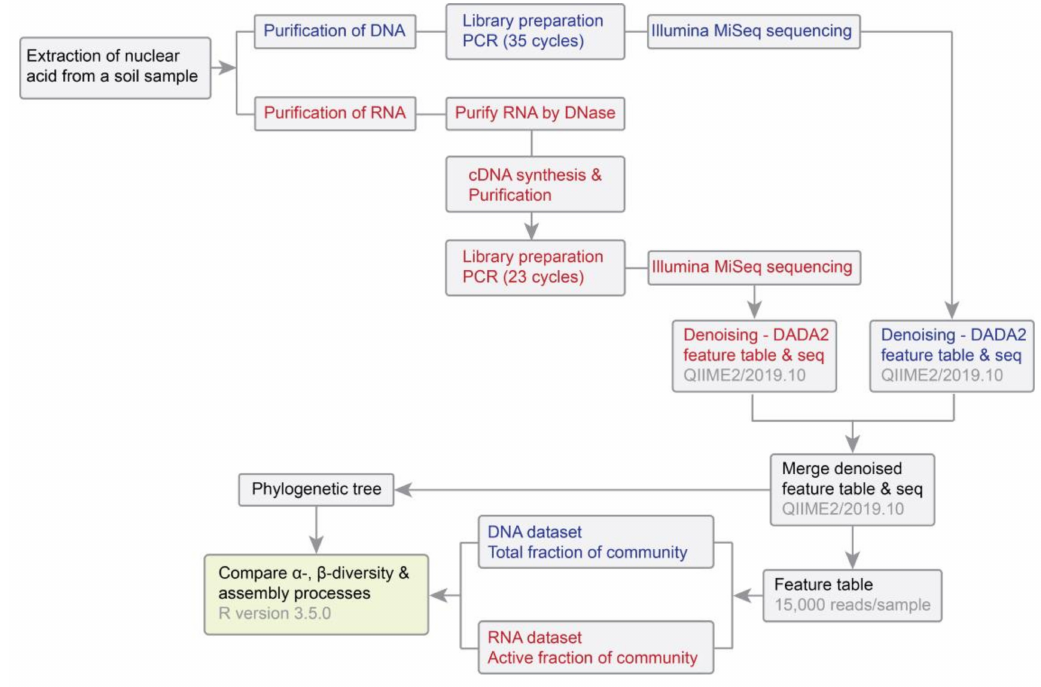
Figure 1. Workflow applied in this study. Procedures for analyzing RNA samples are shown in red, procedures for analyzing DNA samples are shown in blue, and common procedures are shown in